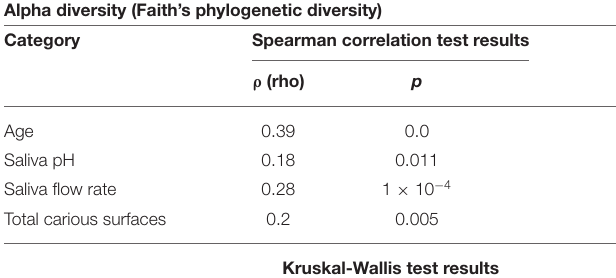
introduction of free sugars that microbes ferment to acid